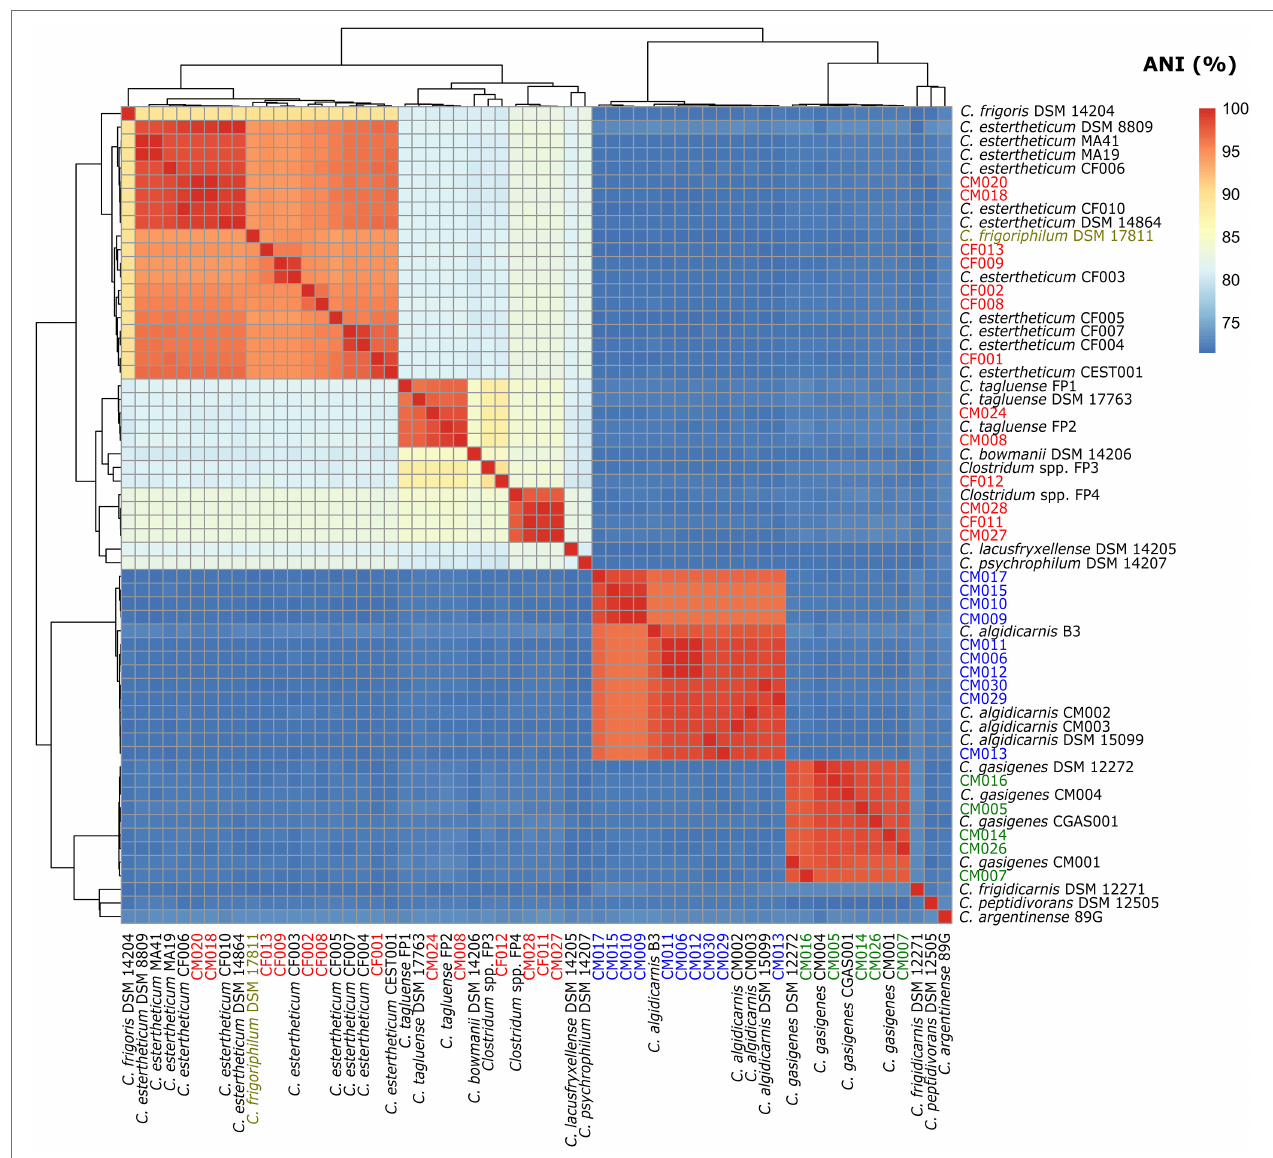
FIGURE 3 | Heat map of average nucleotide identity (ANI) analysis of 28 Clostridium spp. strains isolated from MJS and BFS and 32 representative clostridia strains. Thirteen isolates belonging to the Clostridium estertheticum complex are highlighted in red. Other isolates within species C. algidicarnis (blue text; n = 10) and C. gasigenes (green text; n = 5) are also highlighted. C. frigoriphilum DSM 17811 is highlighted in